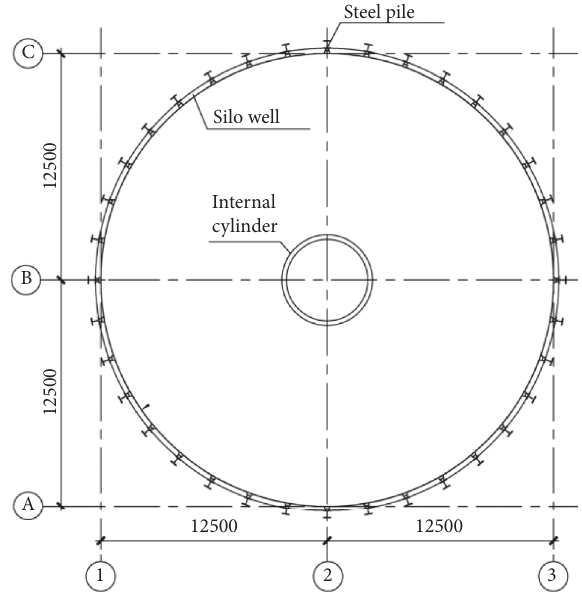
Figure 2: Plane layout of the prefabricated underground silo composite